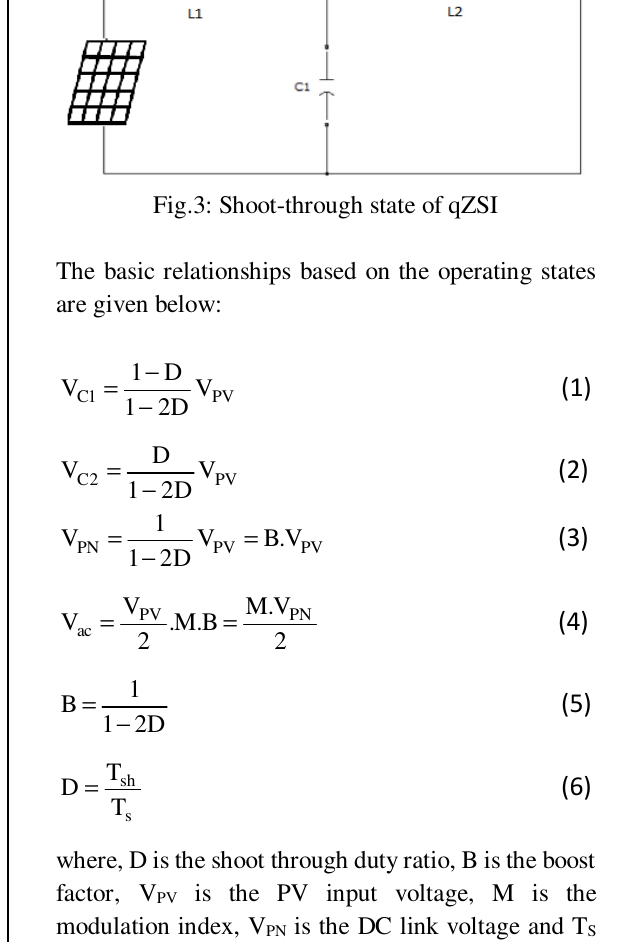
Fig. 1: PV based five-level qZSI